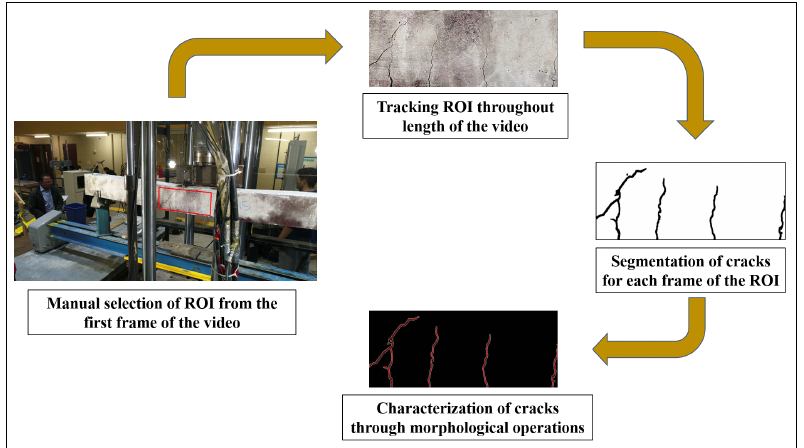
Figure 7. Flowchart of steps used in post-processing of recorded video frame by